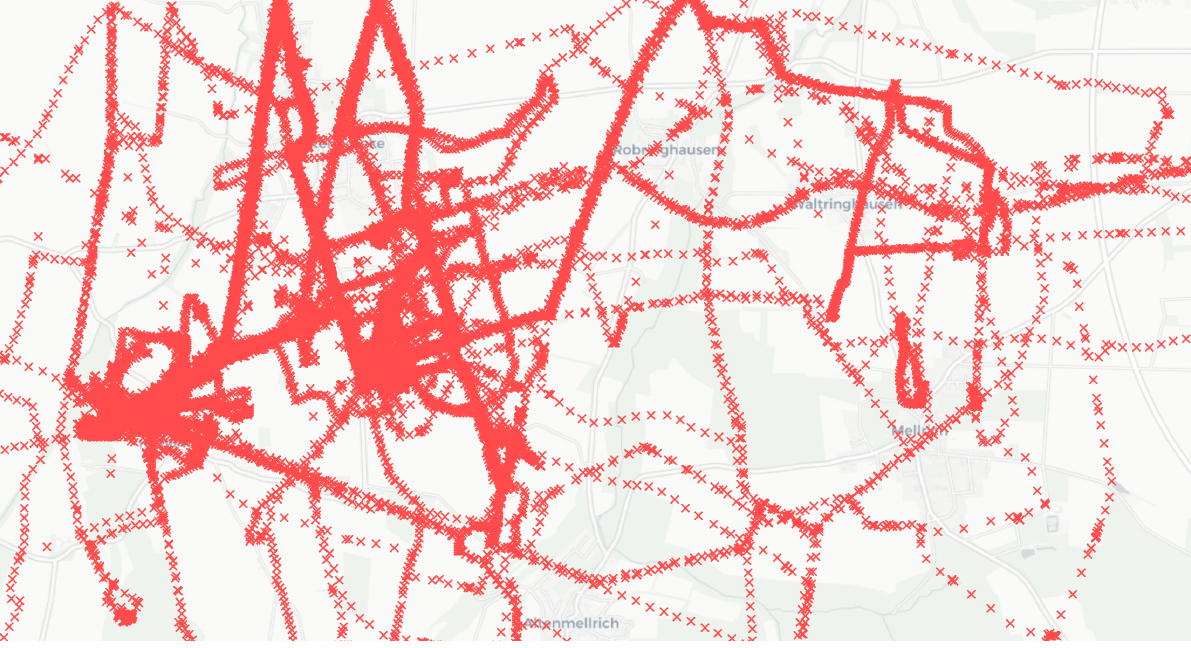
Figure 2. Excerpt of the GPS samples. This plot shows approximately only one-third of the entire dataset. Trip intervals can be identified by the continuous lines they form. Trajectories do not match streets on the background